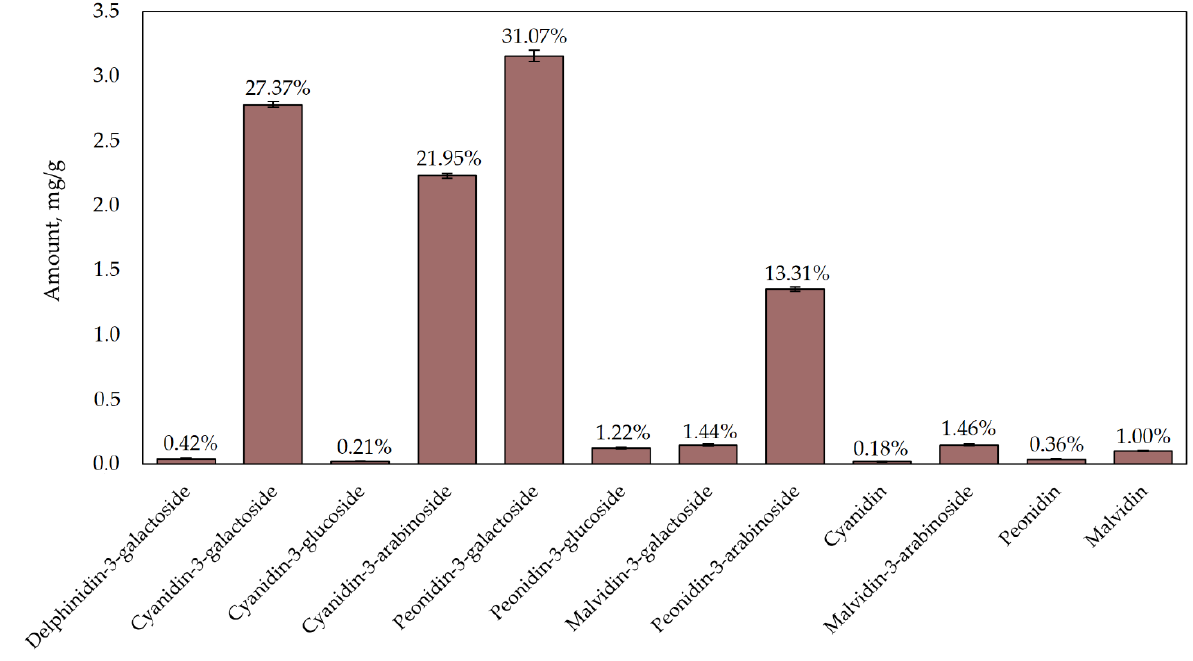
Figure 2. Concentration of individual anthocyanins in ethanol extracts obtained from the fruit of the ‘Dižbrūklene’ cranberry cultivar.